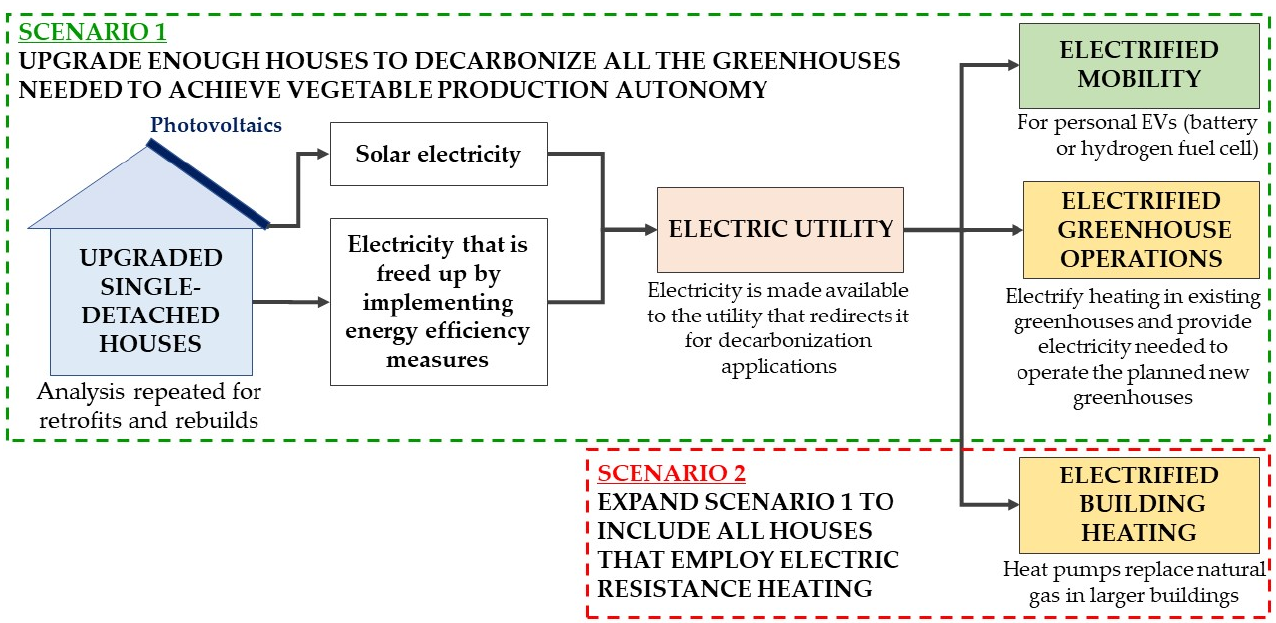
Figure 3. Diagram showing the two main scenarios considered in this